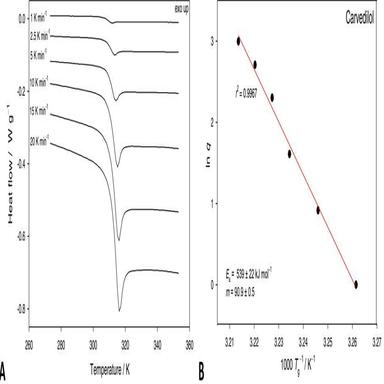
(A) DSC curves of amorphous carvedilol at different heating rates. (B) Determination of the activation energy and fragility parameter of carvedilol by DSC. "Arrhenius plots" of the logarithm of the heating rate, q, as a function of 1000/Tg, where Tg is the temperature of the extrapolated onset of the glass transition step signal.